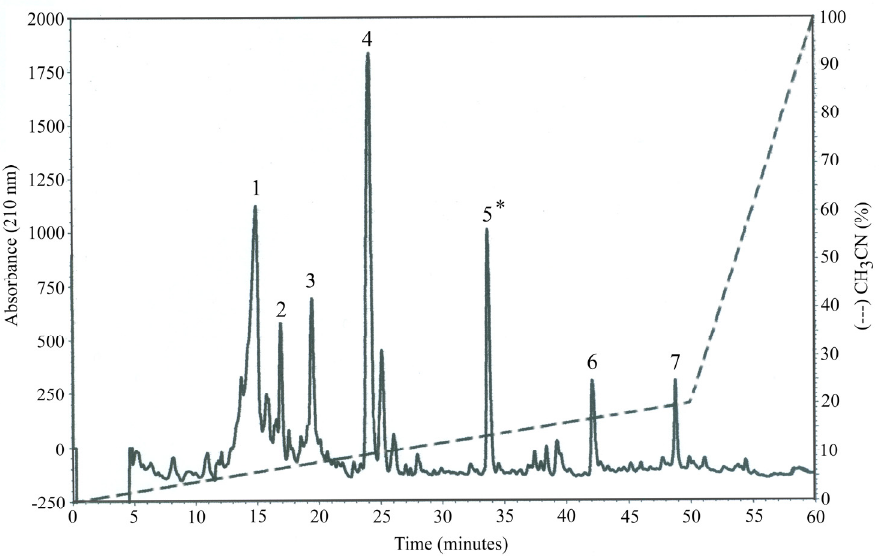
Figure 1. Major chromatographic peaks (n.7) obtained from OP-W1. The most bioactive aqueous adsorbable extract result was the fifth one (*), by HPLC-DAD.